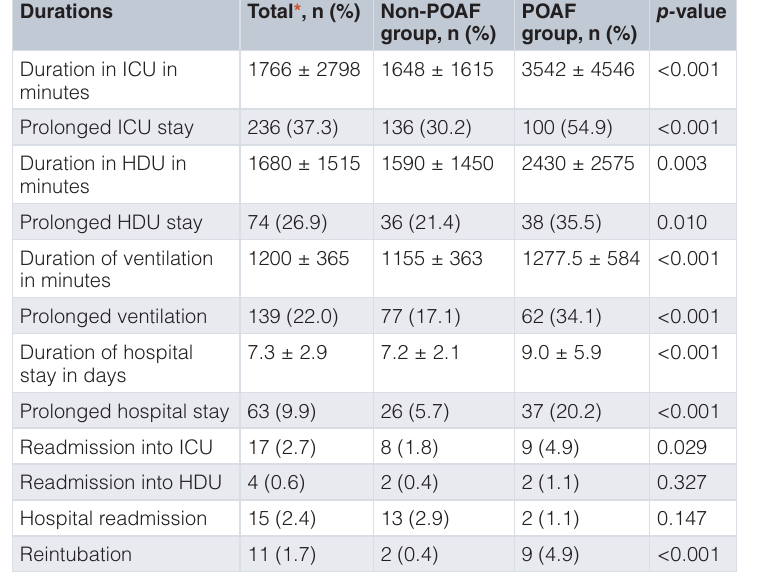
Table 9. Association between post-operative atrial fibrillation (POAF) and duration of stay, as well as duration of ventilation. ICU, intensive care unit; HDU, high dependency